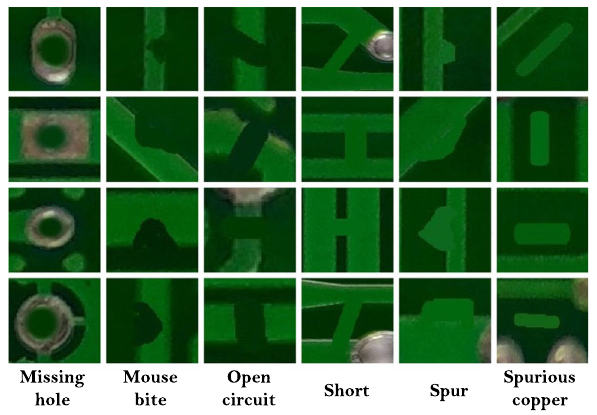
Figure 4. Annotated extracted defect contours (EDCs) 29